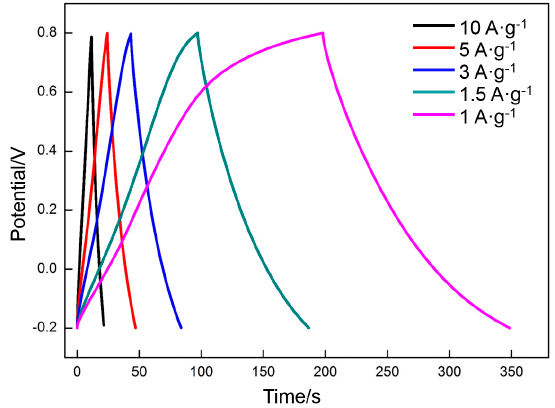
Figure 14. Galvanostatic charge/discharge curves of RGO at different current densities.